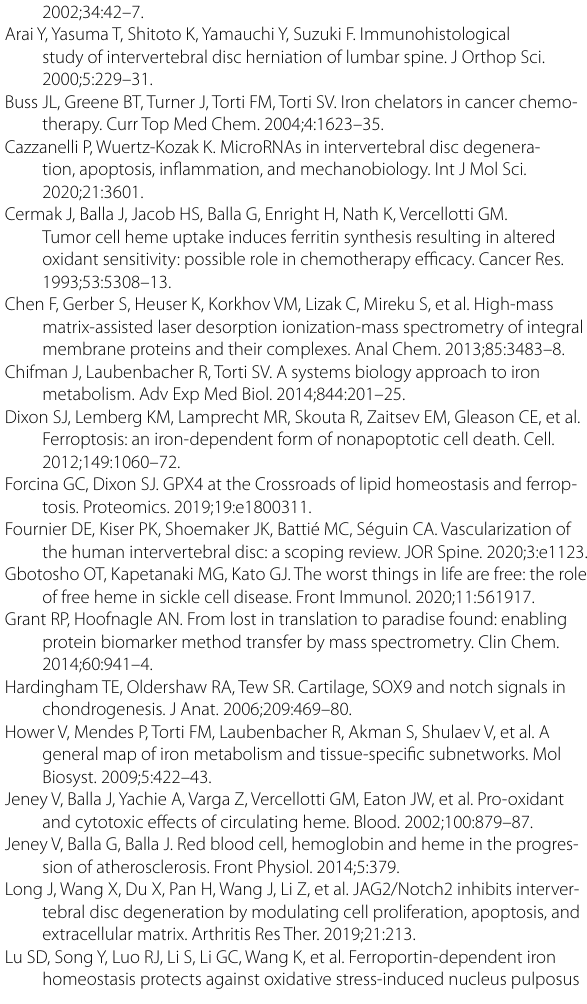
Additional file 2: Table S1. Identification results of potential biomark- ers in human lumbar discs. Table S2. Identification results of potential biomarkers in nucleus pulposus